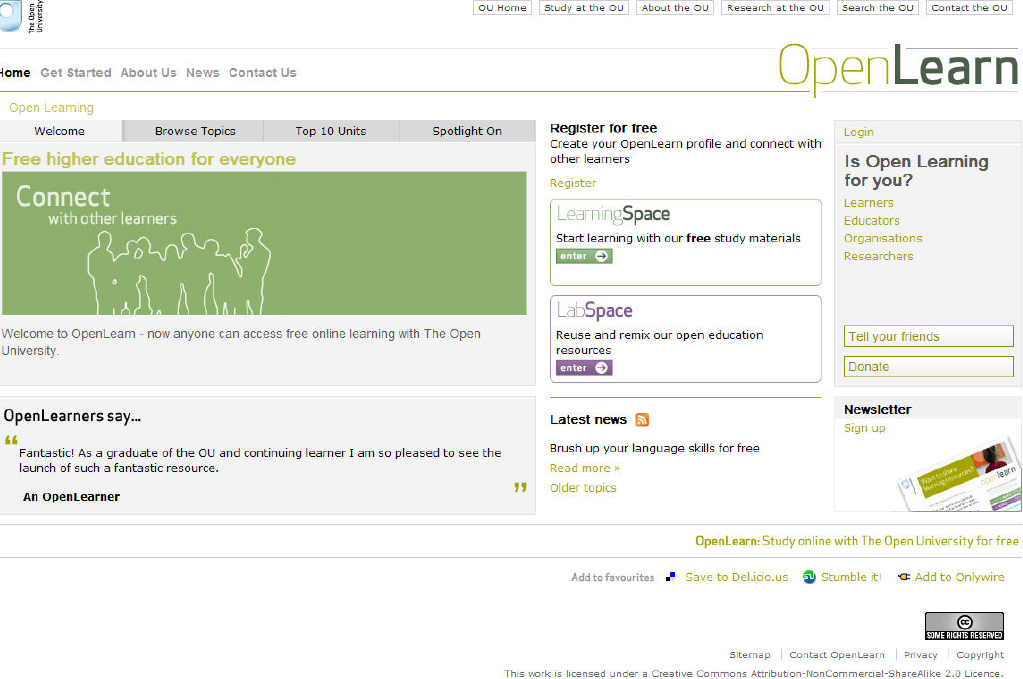
Figure 1 . The OpenLearn website showing linked captions to the LearningSpace and LabSpace